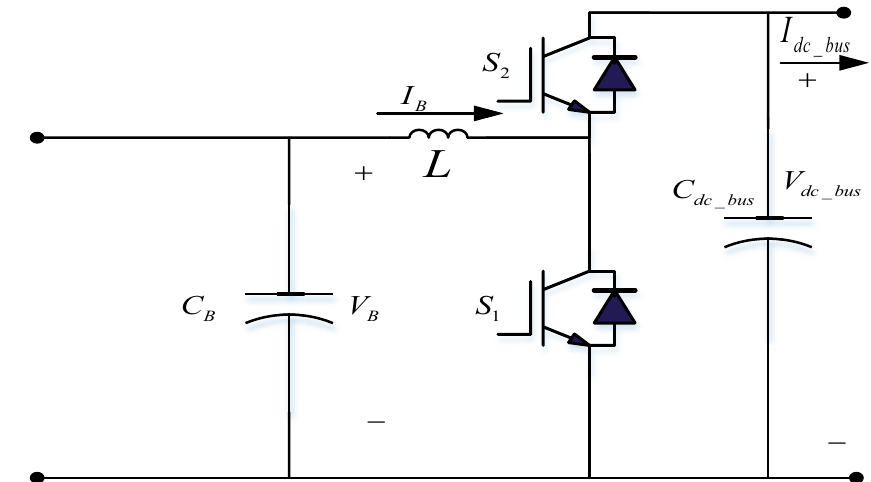
Figure 10. The bidirectional buck/boost converter circuit.